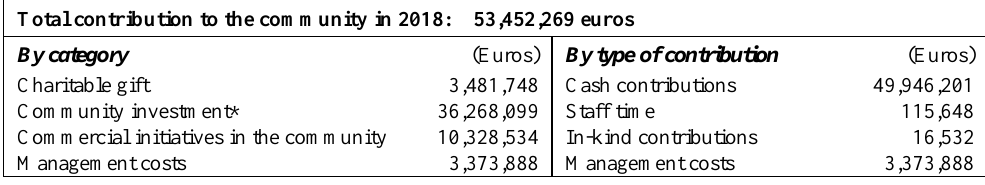
Table 1: Iberdrola’s Community Investment in